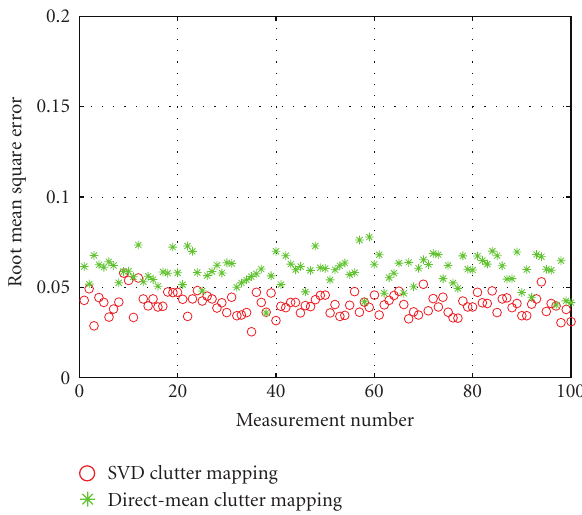
Figure 9: RMSE values for evaluation of the SVD and the direct- mean method without moving target.